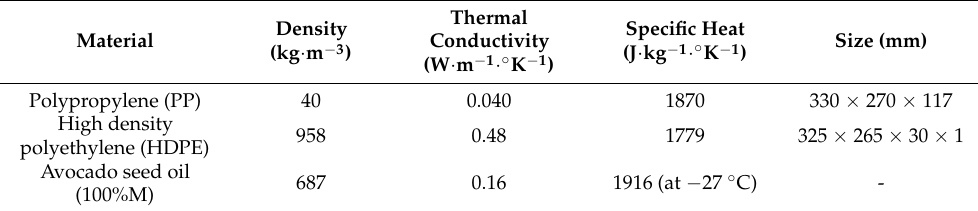
Table 2. Simulation characteristics for isothermal box, PCM box and PCM.